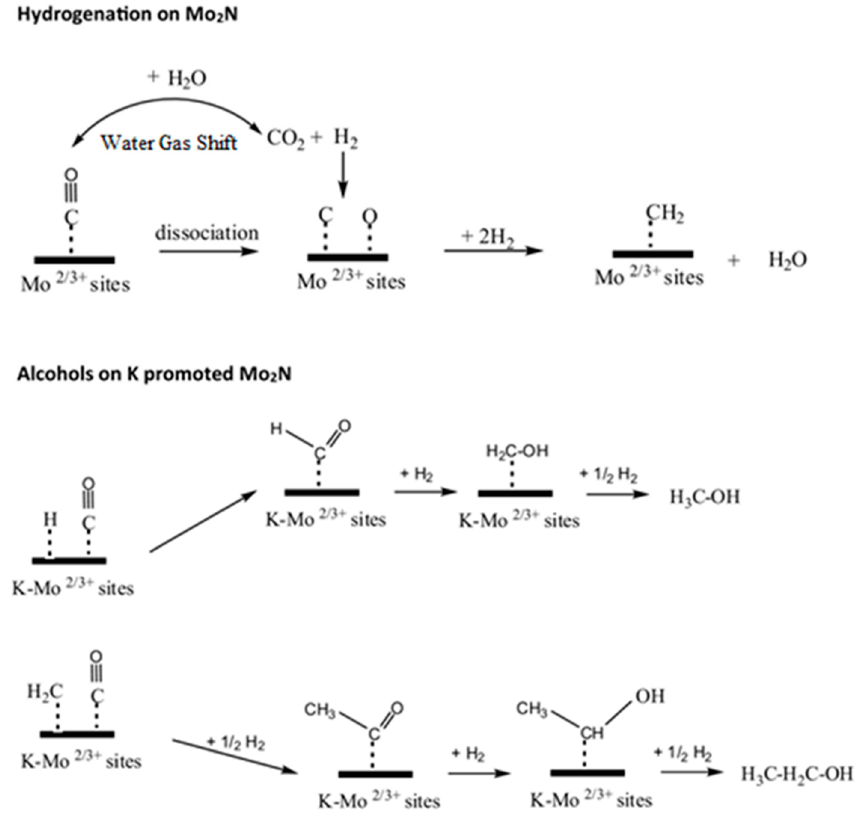
Figure 3. Plausible CO hydrogenation reaction pathways on Mo 2 N and K-Mo 2 N